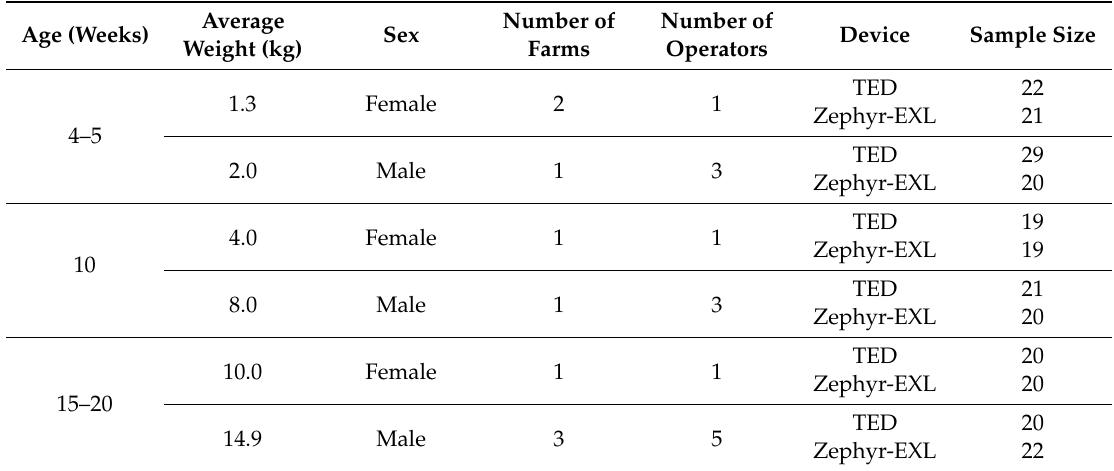
Table 1. Description of sample sizes and device distribution across age, sex, farm, and operator.